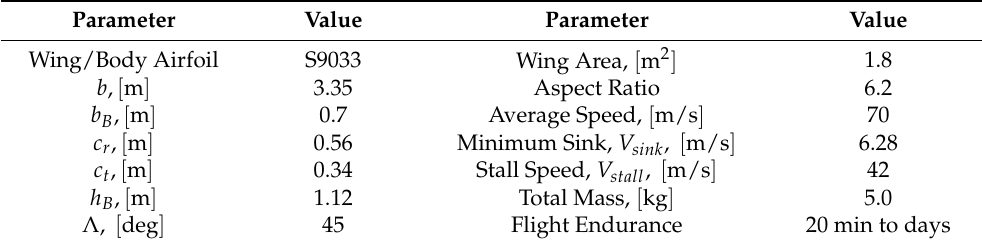
Figure 2. ( a ) Sailplane platform; ( b ) 3D-rendering. Table 1. Specifications of Mars